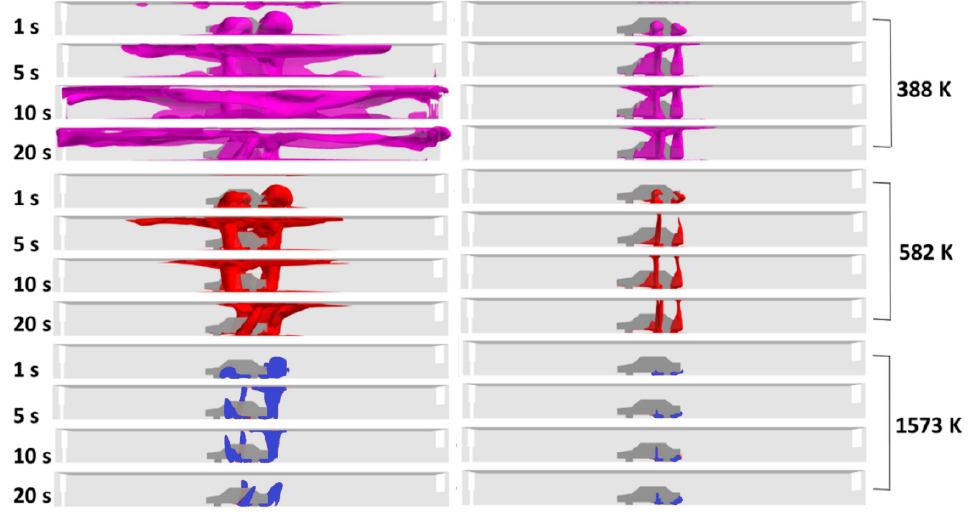
Figure 11. Side view iso-surface showing pain (388 K), fatality (582 K) limits and visible flame tem- perature (1573 K) for case 4 with TPRD = 2 mm ( left ) and case 9 with TPRD = 0.5 mm ( right ).